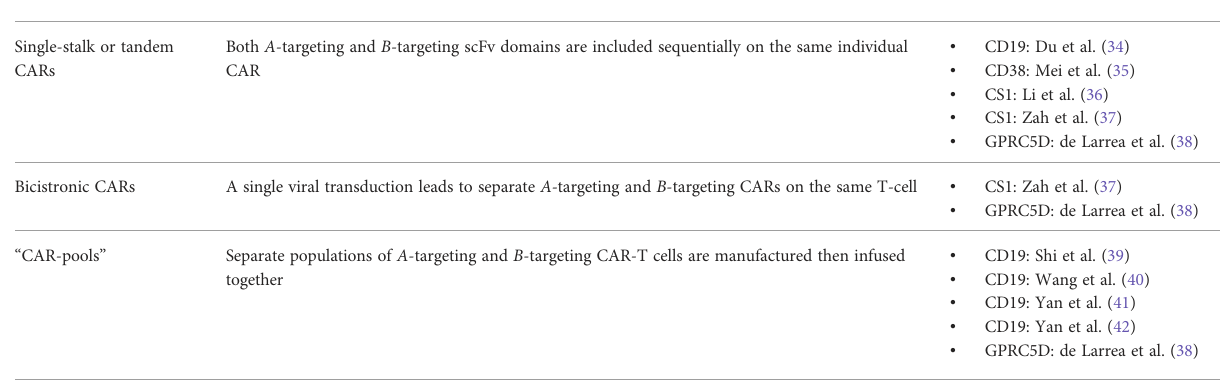
Single-stalk or tandem